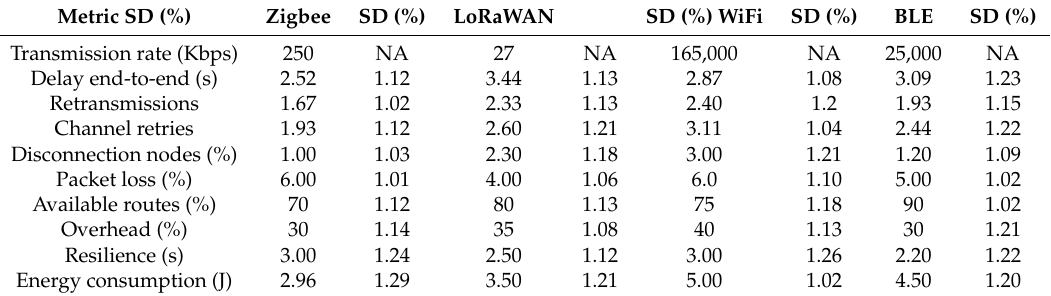
Table 2. Nodes under the cooperative